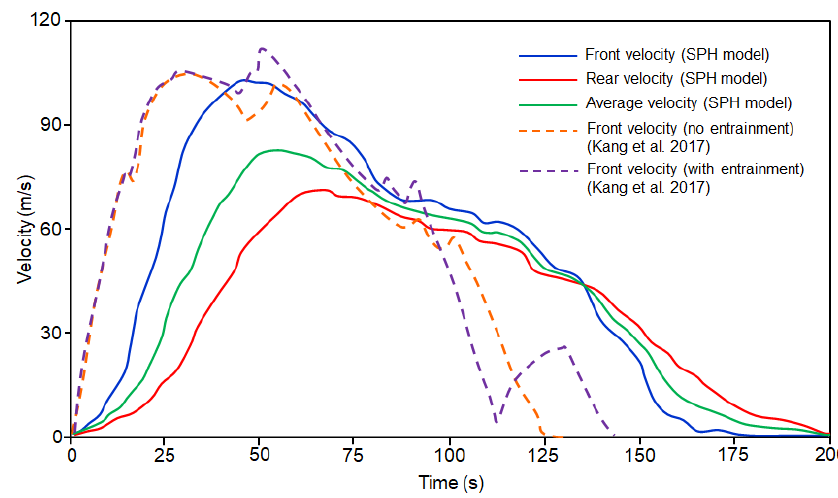
Figure 8. Velocity–time history curves of different parts of the debris flow.